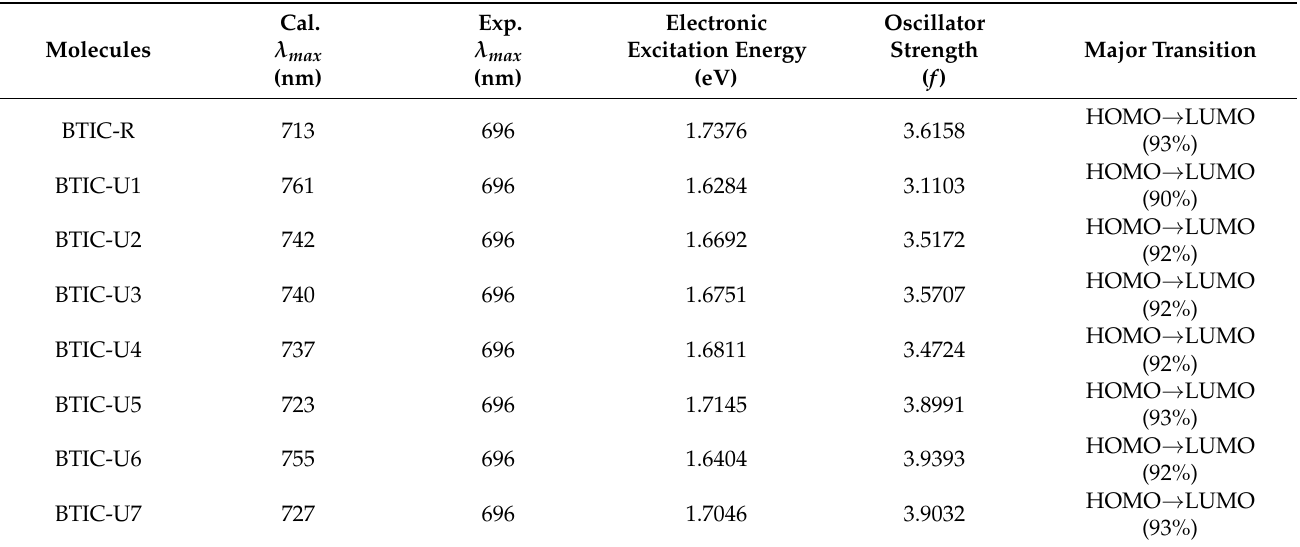
Table 3. Solvent phase computed transition character, oscillator strength (ƒ), transition energy (eV),